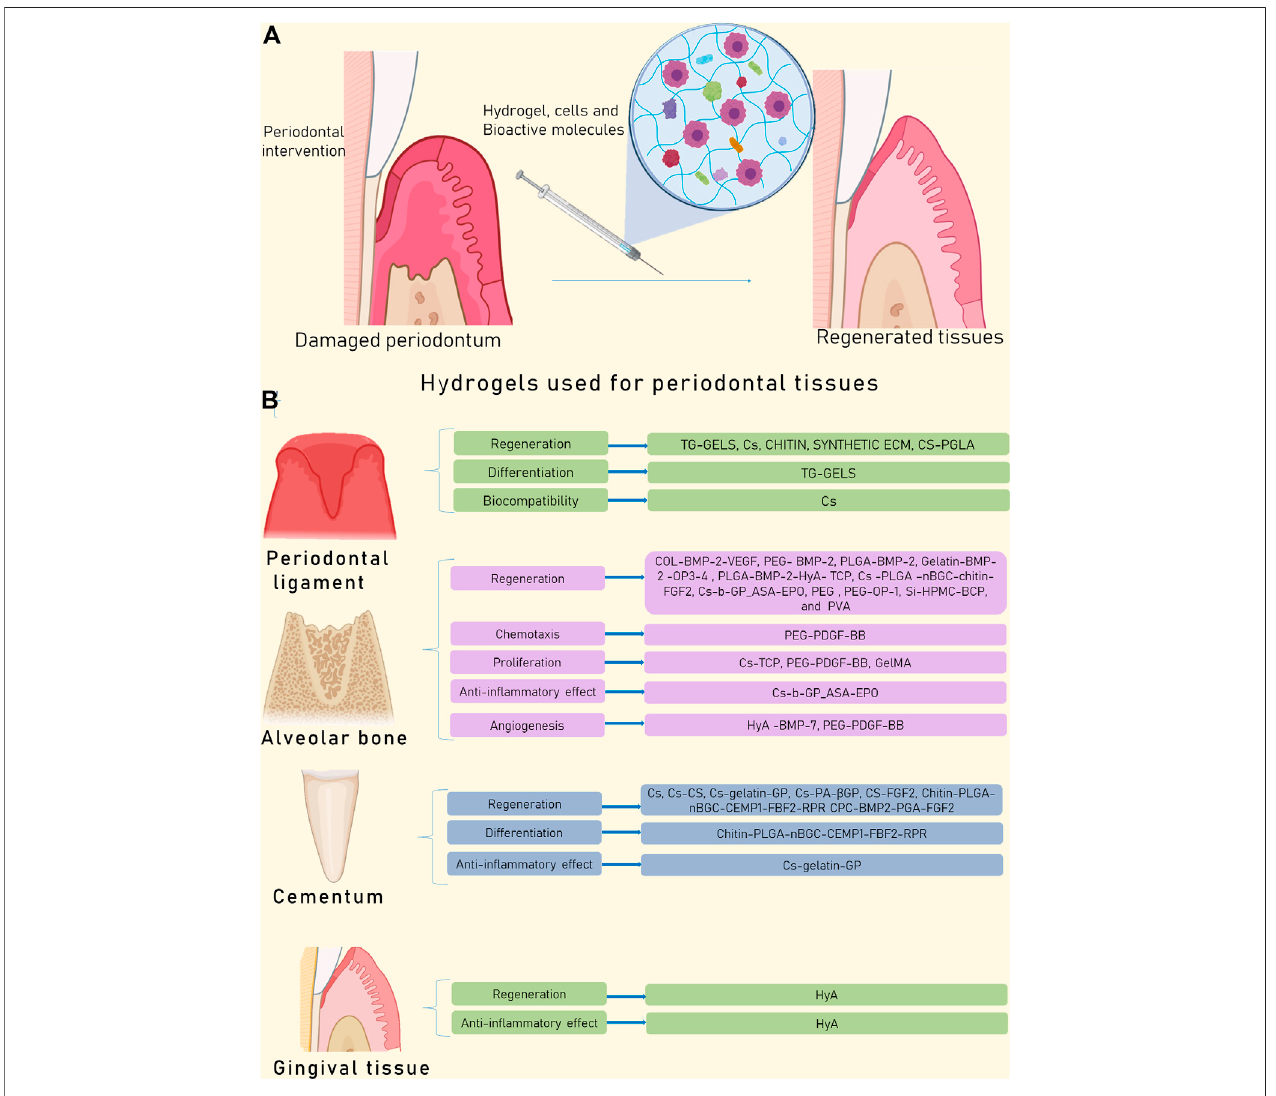
FIGURE2| Thecompleteregenerationoftheperiodontiumisnotpossibleyetgiventhecomplexcharacteristicsofthetissues. (A) HGareapromisingalternativeto restorethestructureandfunctionoftheperiodontalcomplex. (B) HGinperiodontalcellscaninducedifferentiation,proliferation,chemotaxis,andangiogenesis,enabling the formation of new tissue. Besides some HG in periodontium show anti-in fl ammatory effect.